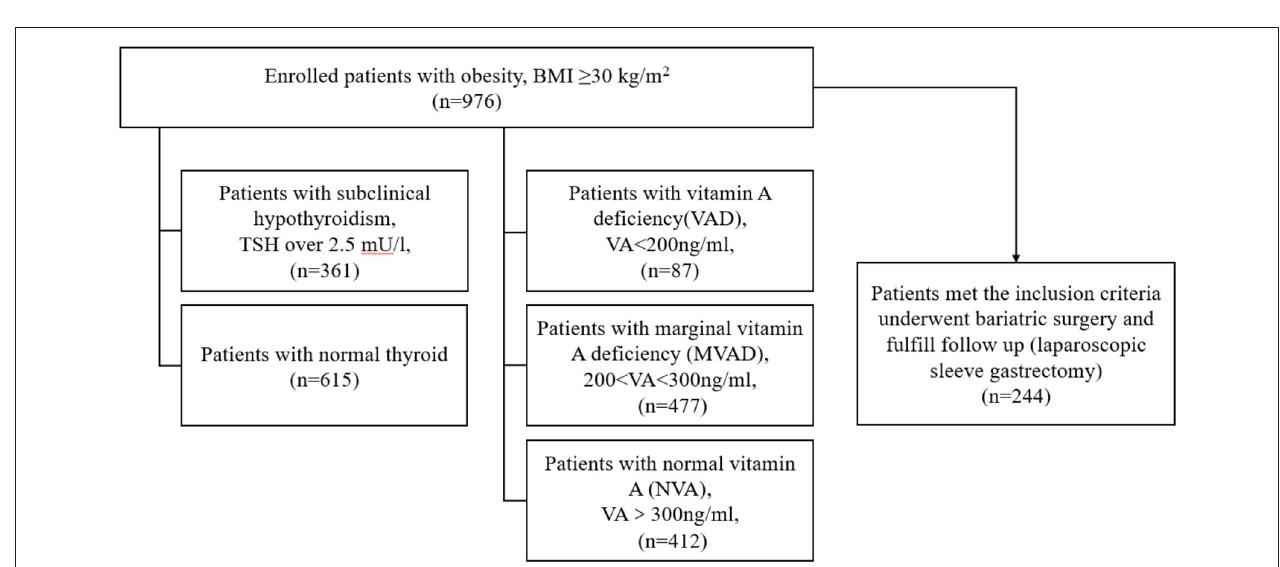
FIGURE 1 | Flowchart of grouping and enrollment in this study.